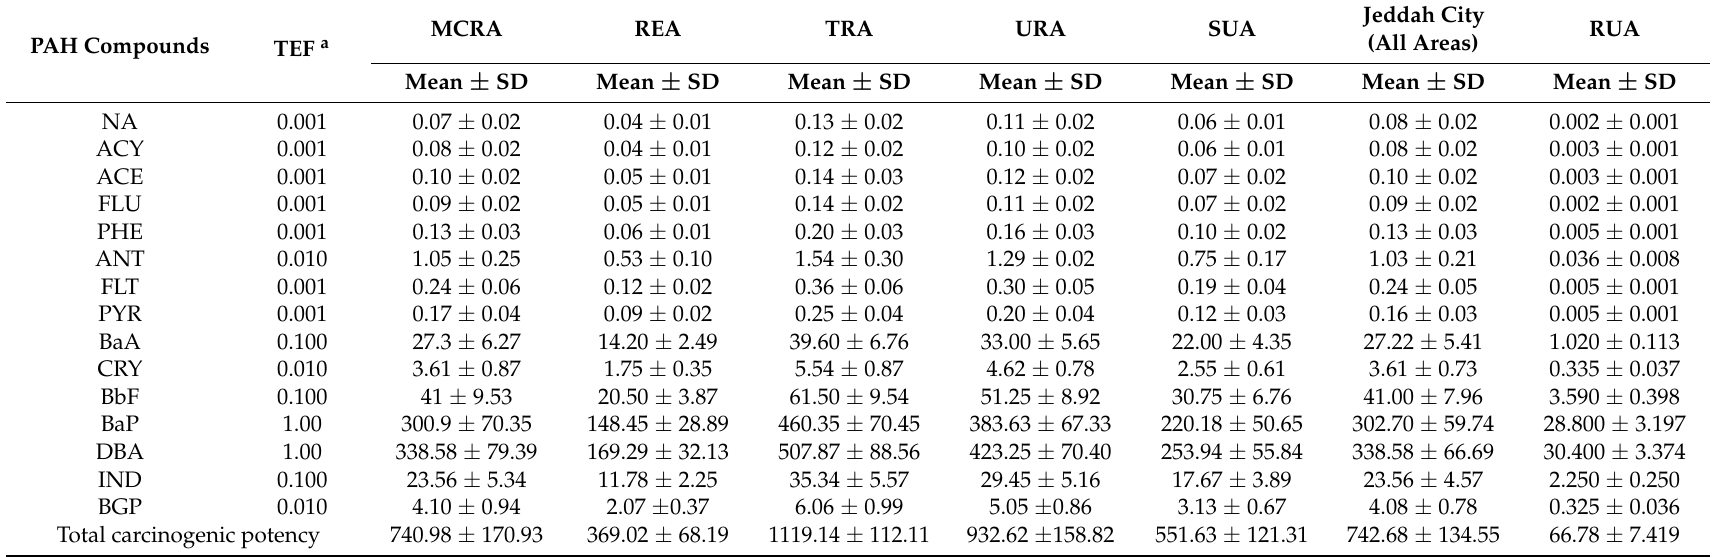
Table 3. BaP equivalent concentration (ng BaP equi /g) for the individual PAH compounds in street dusts collected from the different areas of Jeddah city and a rural area (RUA) of Hada Al Sham.